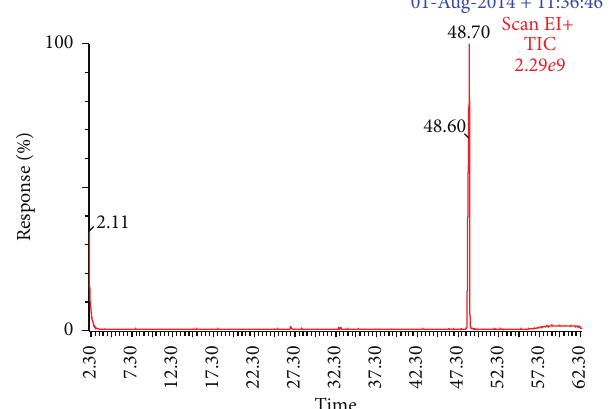
Figure 1: GC-MS chromatogram of squalene standard (20 𝜇 L). Showing its response at the 49th minute.